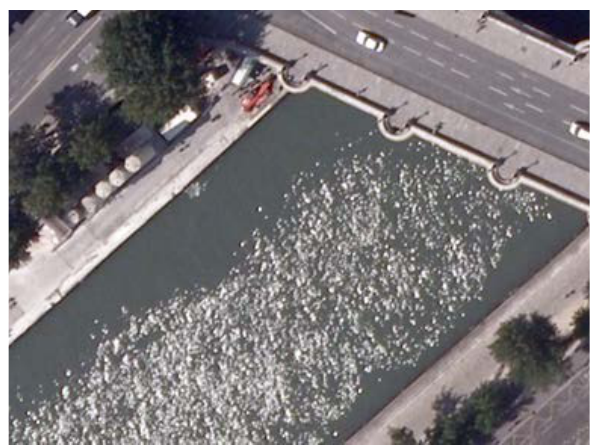
Fig. 11: Irritating wave reflections in water bodies